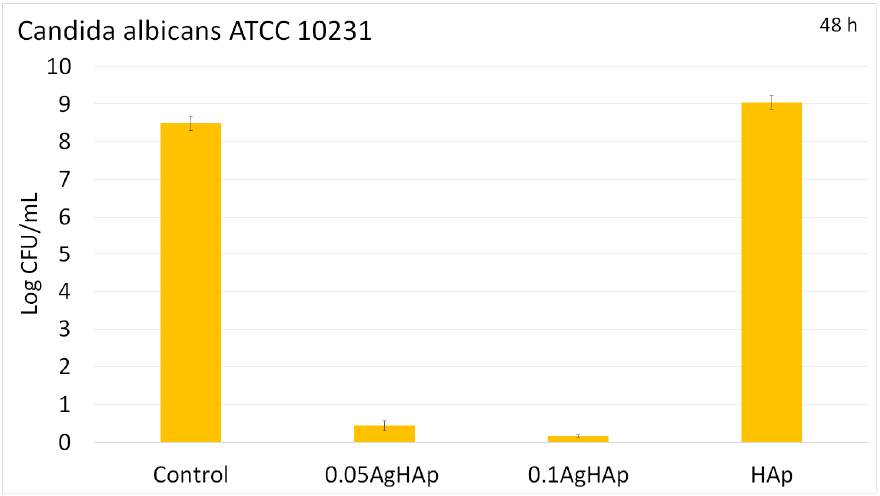
Figure 15. The graphical representation of CFU/mL of HAp, 0.05 AgHAp, and 0.1 AgHAp thin films after 48h of exposure to Candida albicans ATCC 10231.